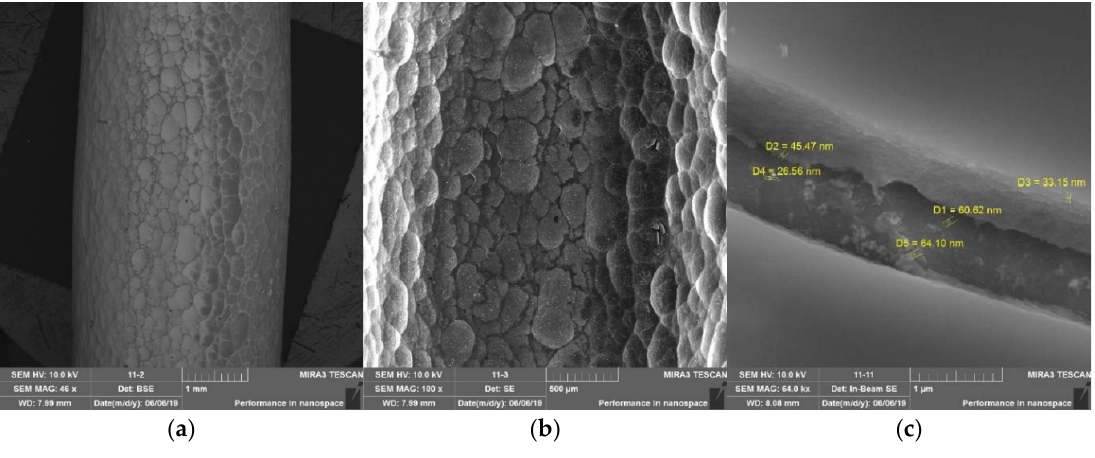
Figure 11. SEM micrographs of the surface of a sample containing one layer of protective coating applied by sequential immersion in tetraethoxysilane and ammonia. ( a ) zoom ×46; ( b ) zoom ×100; ( c ) zoom ×64,000.